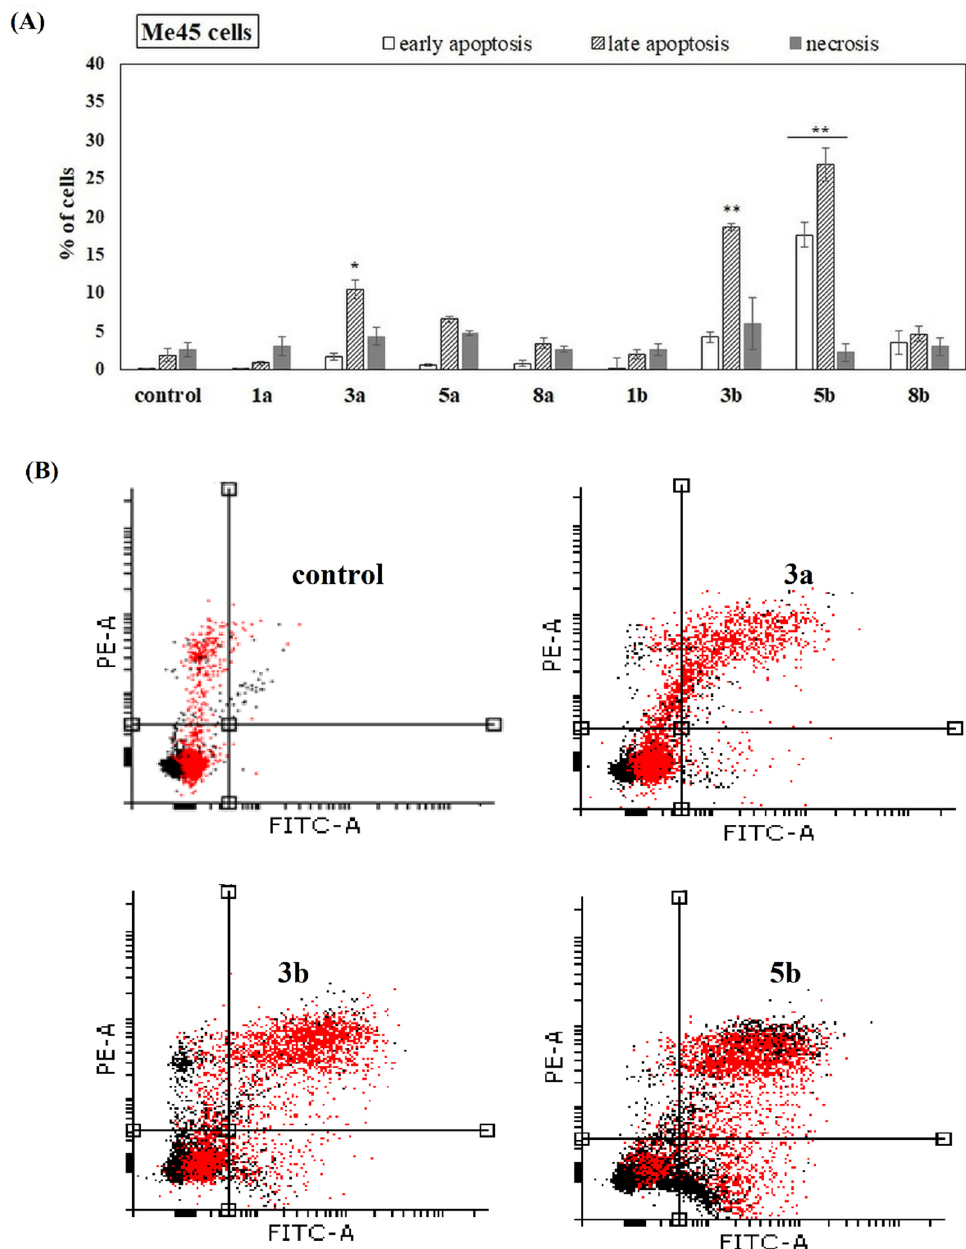
Figure 8. Induction of apoptosis in Me45 cells in the presence of the studied compounds. Cells were cultured for 72 h in the presence of the studied chemicals (at 100 μ M). The percentage of necrotic, early and late apoptotic cells was shown. The statistical significance was determined (* p < 0.05 and ** p < 0.001) ( A ). Representative histograms of events defined after forward and side scatters as cells (red dots) and debris (black dots) are shown ( B ).